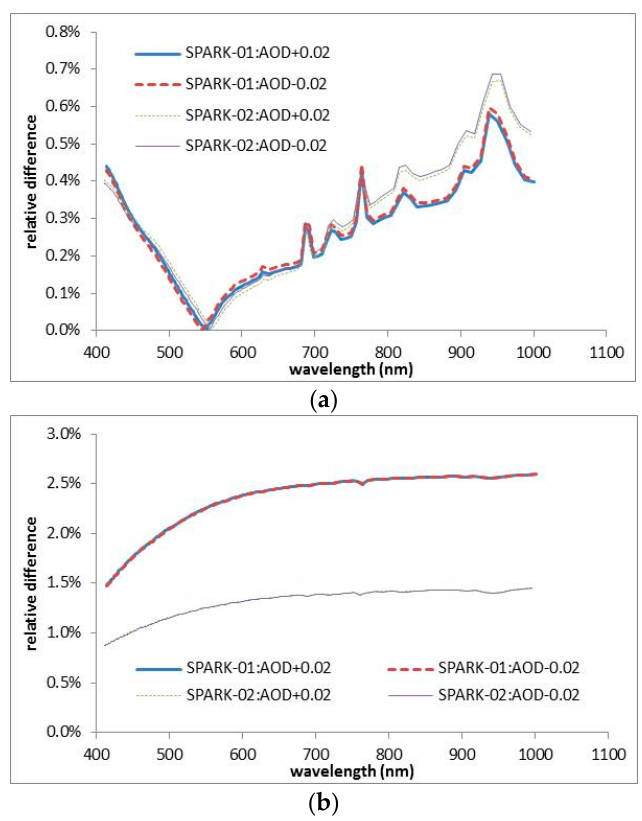
Figure 25. Calibration uncertainties caused by the AOD measurements for SPARK-01 and -02 using the ( a ) reflectance- and ( b ) irradiance- based (or improved irradiance-based) methods,